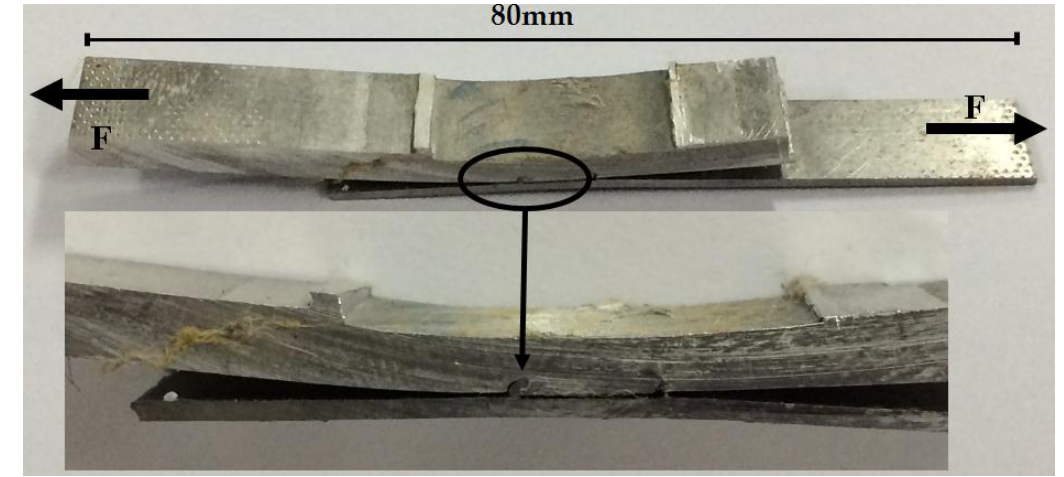
Figure 11. Specimen after tensile test of friction stir welded 6061-T6 aluminum alloy to ultra low carbon steel. F: Force used during a test. Fractured zone is presented.